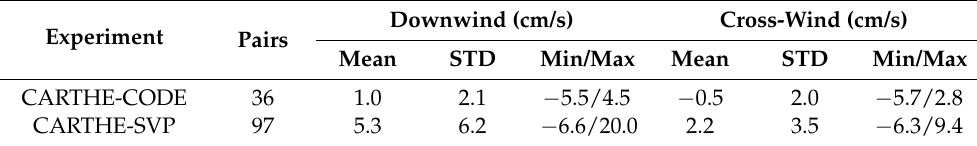
Table 3. Statistics of the difference between pairs of drifters on 9 April 2019 between 08:45 and 20:47 UTC.